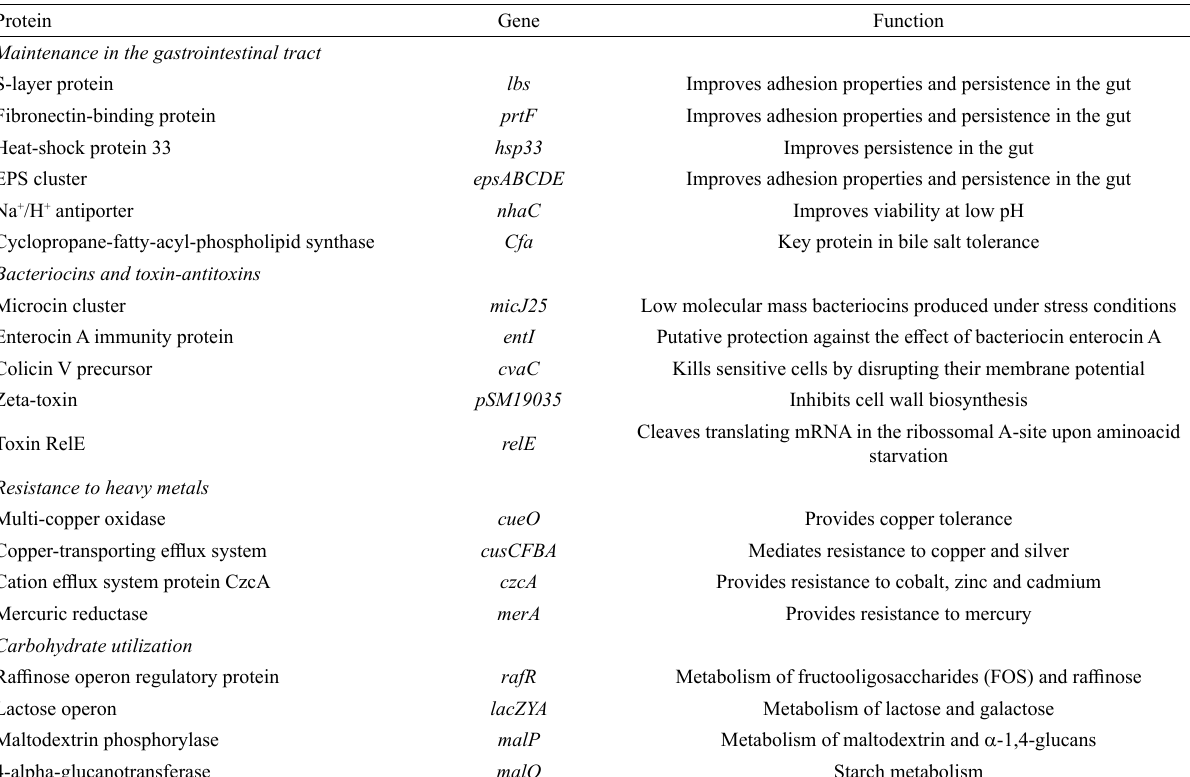
Table 2 – Genes associated with potential probiotic properties of E. durans LAB18S.